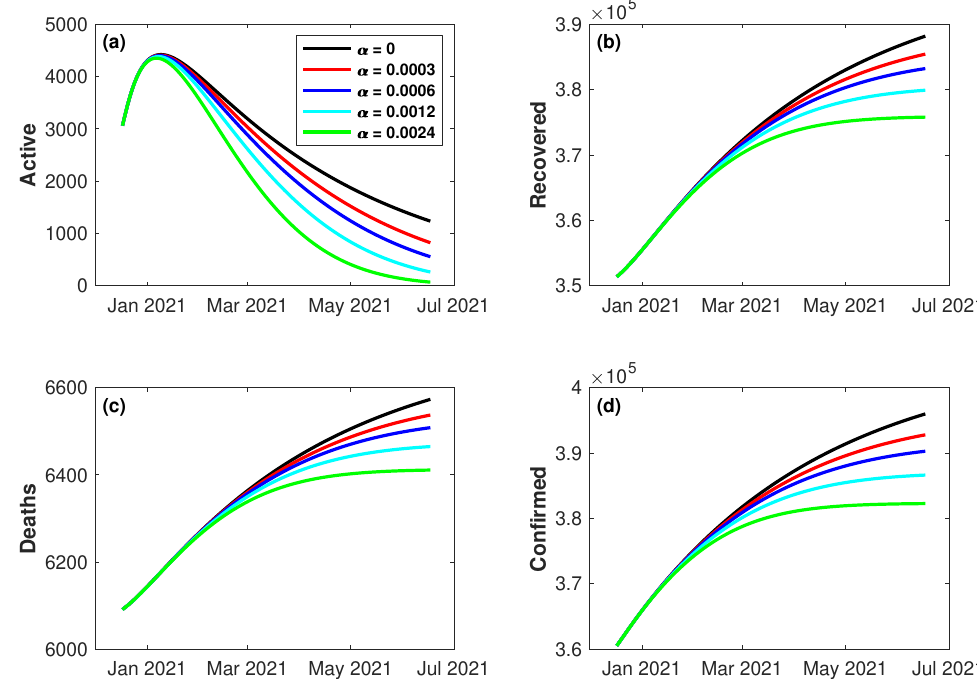
Figure 7. Impact of vaccination rate on the total number of: ( a ) Active cases. ( b ) Recovered cases. ( c ) Death cases. ( d ) Confirmed cases. α = 0 corresponds to the model output without